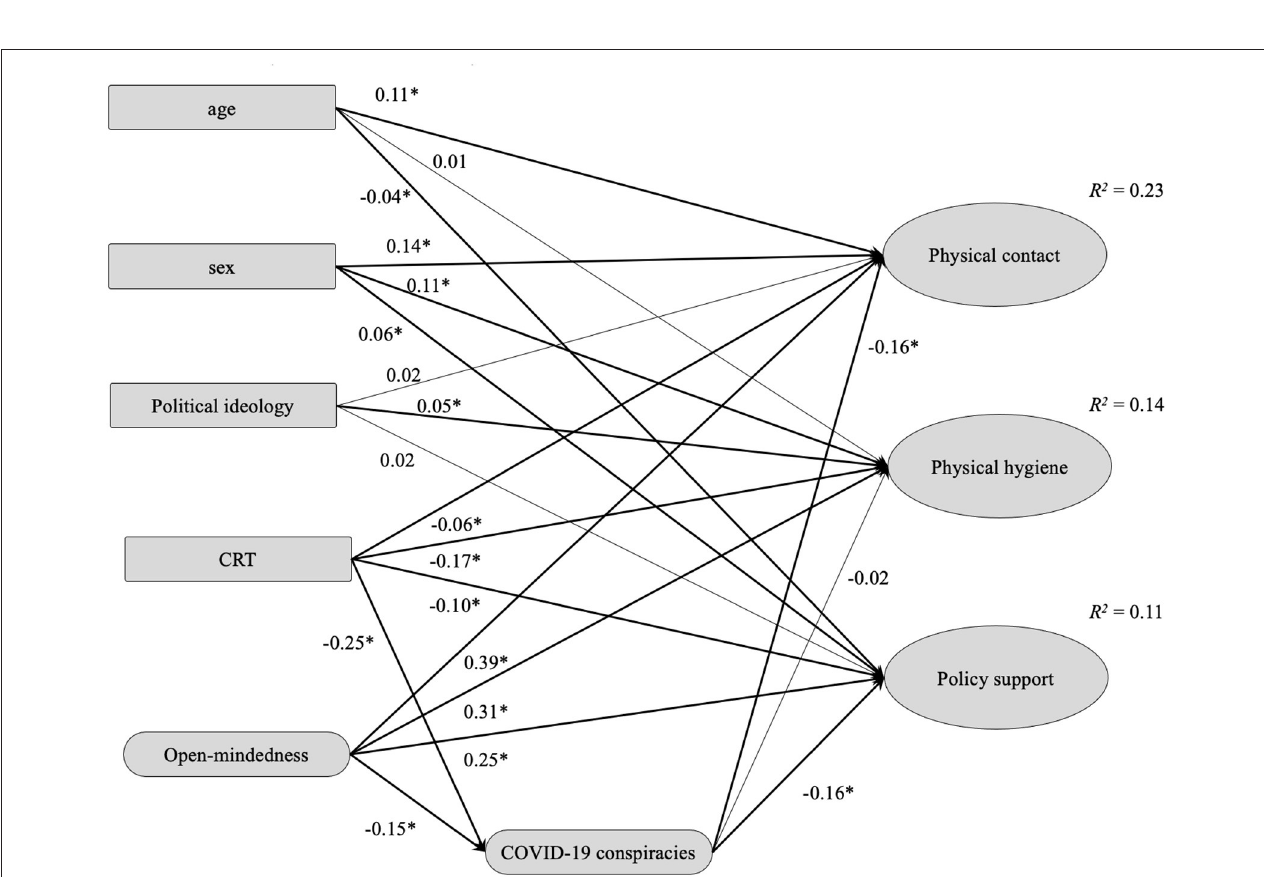
FIGURE 2 | Structural equation modeling of belief in COVID-19 conspiracies as a mediator of the relationship of open-mindedness and CRT with COVID-19 preventive behaviors and policy support ( N = 12,490). Values shown are standardized regression coefficients. Latent variables are denoted as ellipse nodes, and observed variables are denoted as rectangle nodes. Sex coded as males = 1 and females = 2; CRT, cognitive reflection. * p < 0.001.